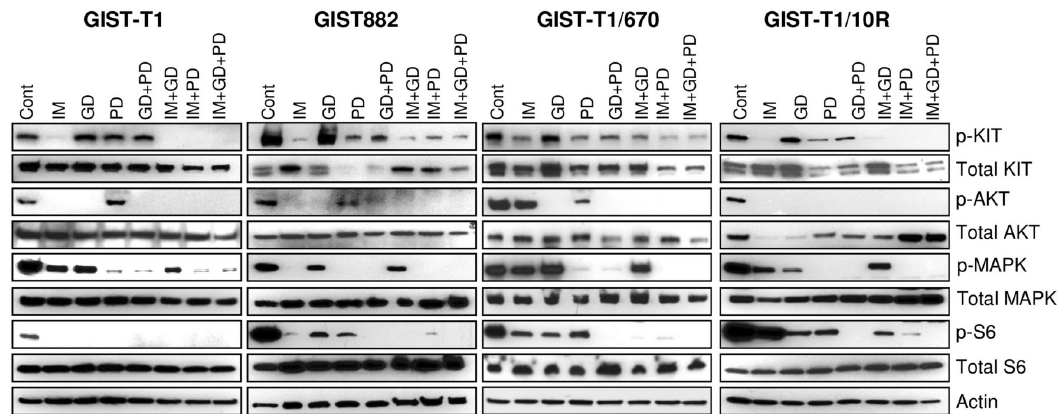
Fig 3. Active MAPK and PI3K signaling in GIST cell lines despite KIT inhibition. Lysates from GIST-T1, GIST882, GIST-T1/670 and GIST-T1/10R cells were analyzed using immunoblots to detect the total and phosphorylated levels of the indicated proteins. Cells were treated with the indicated inhibitors for 24 h–IM: imatinib (1 μ M); GD: GDC-0941 (500 nM), PD: PD0325901 (500 nM). Data is representative of two independent